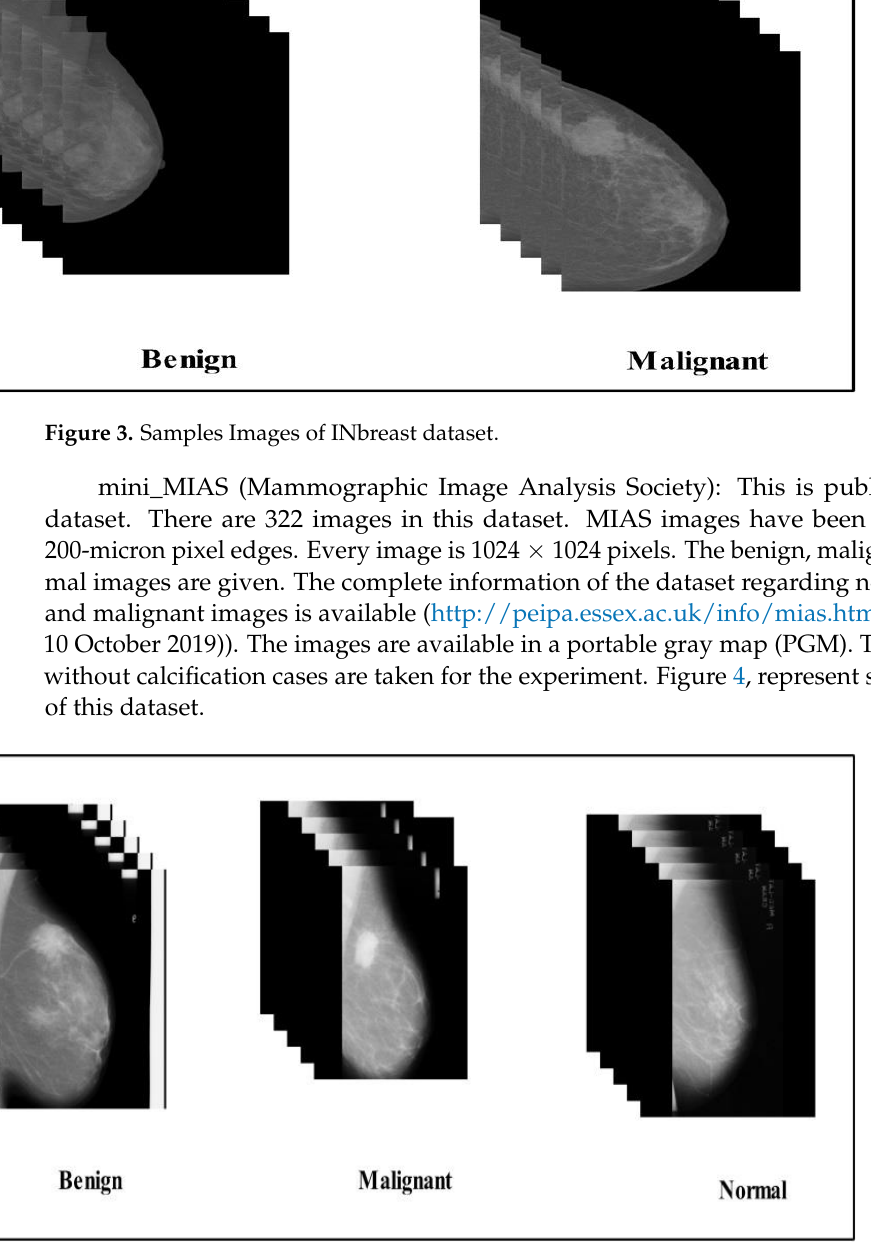
Figure 2. Sample images CBIS-DDSM.